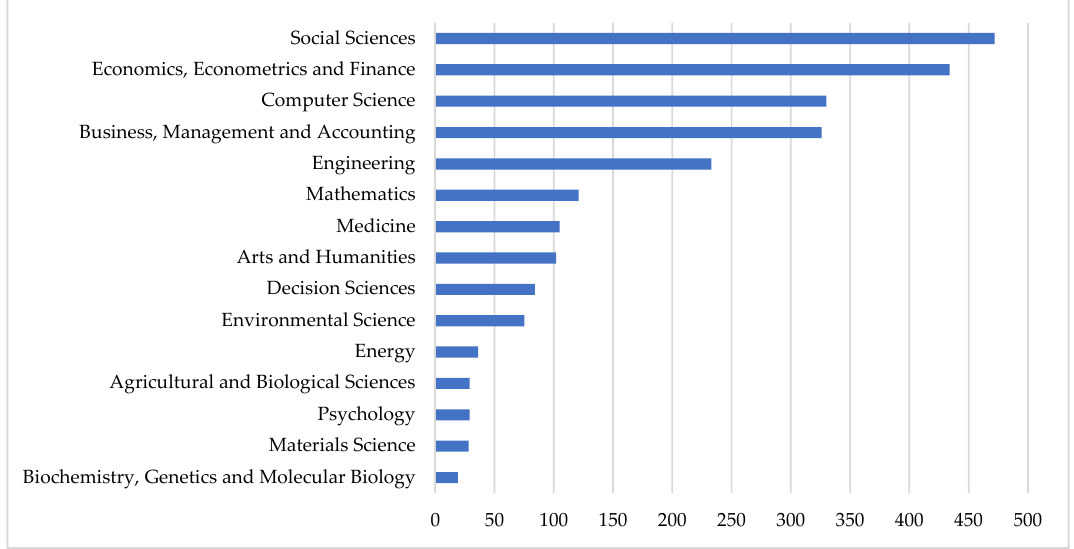
Figure 4. Main thematic areas on financial transactions (1935–2019).